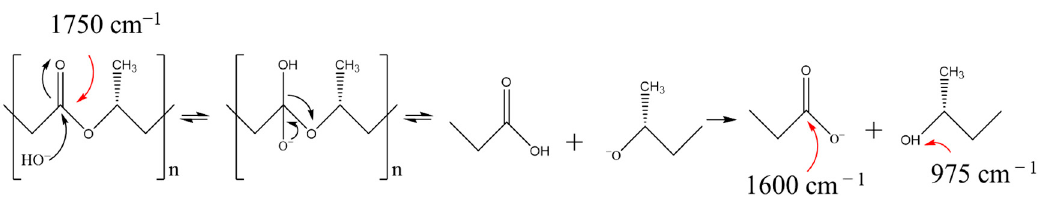
Figure 5. Hydrolytic chain cleavage mechanism of PLA [34] and the most significant infrared bands for monitoring the reaction by FTIR.